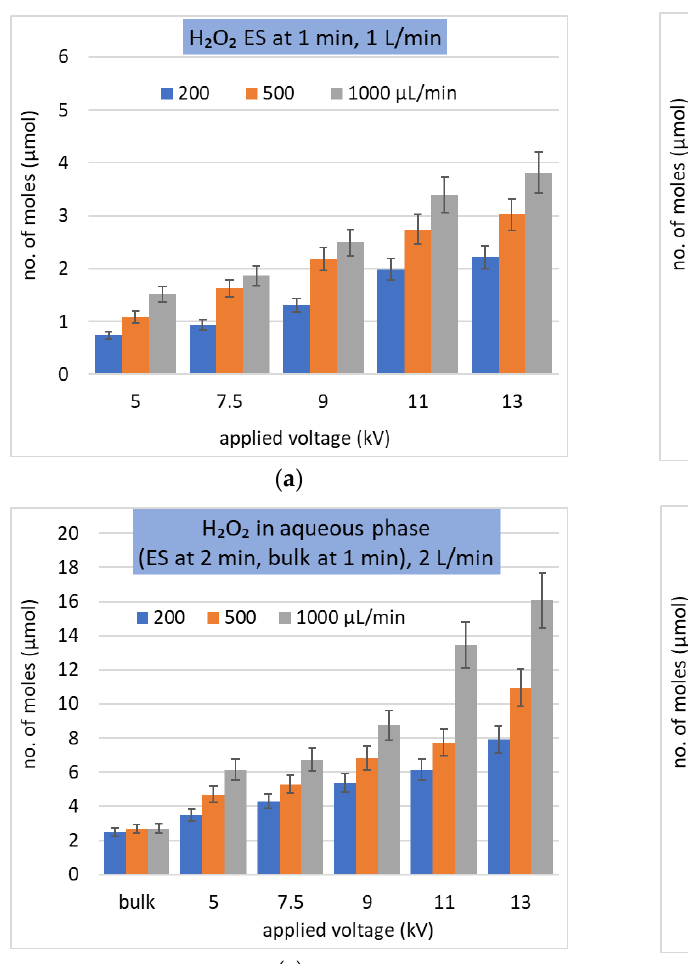
Figure 7. Solvation of O 3 as a molar number of dissolved molecules in ES at a constant gas flow rate (L/min). ( a , b ) two values of constant Q w (µL/min) and different treatment times (min); ( c , d ) different Q w (µL/min) during different treatment times (min) in ES and bulk water.